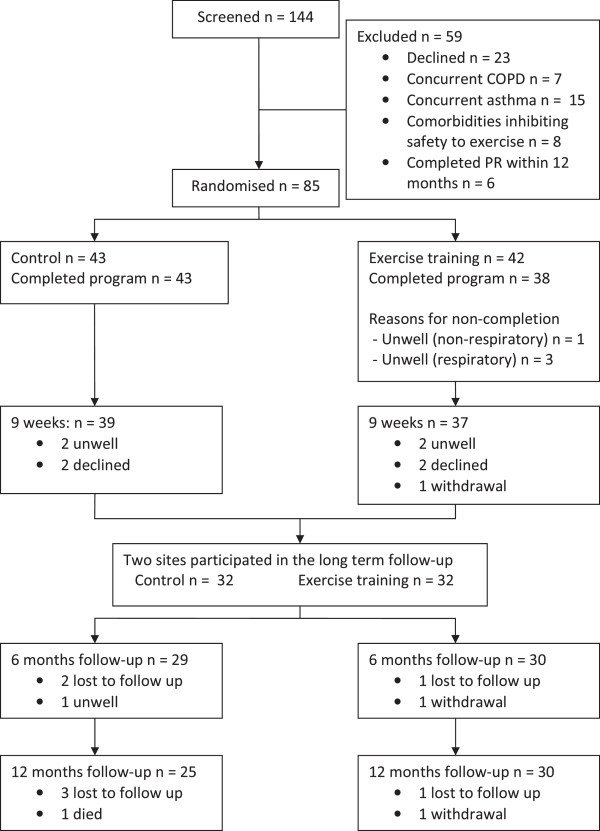
Flow of participants.